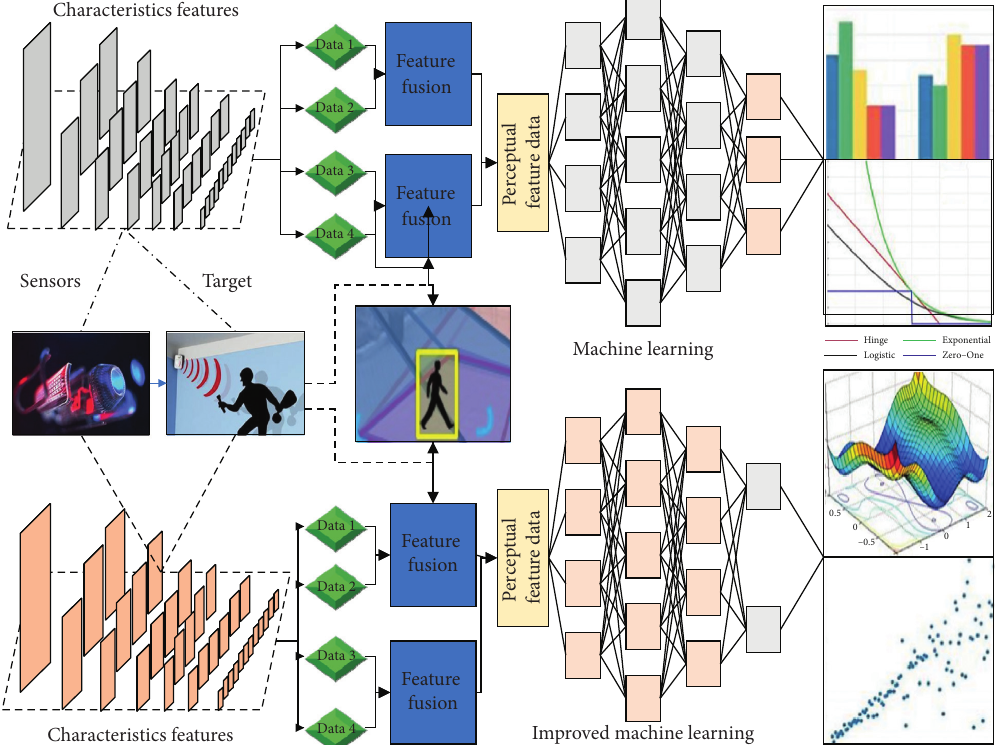
Figure 3: Flow chart of the genetic algorithm for solving the MCCSVRR